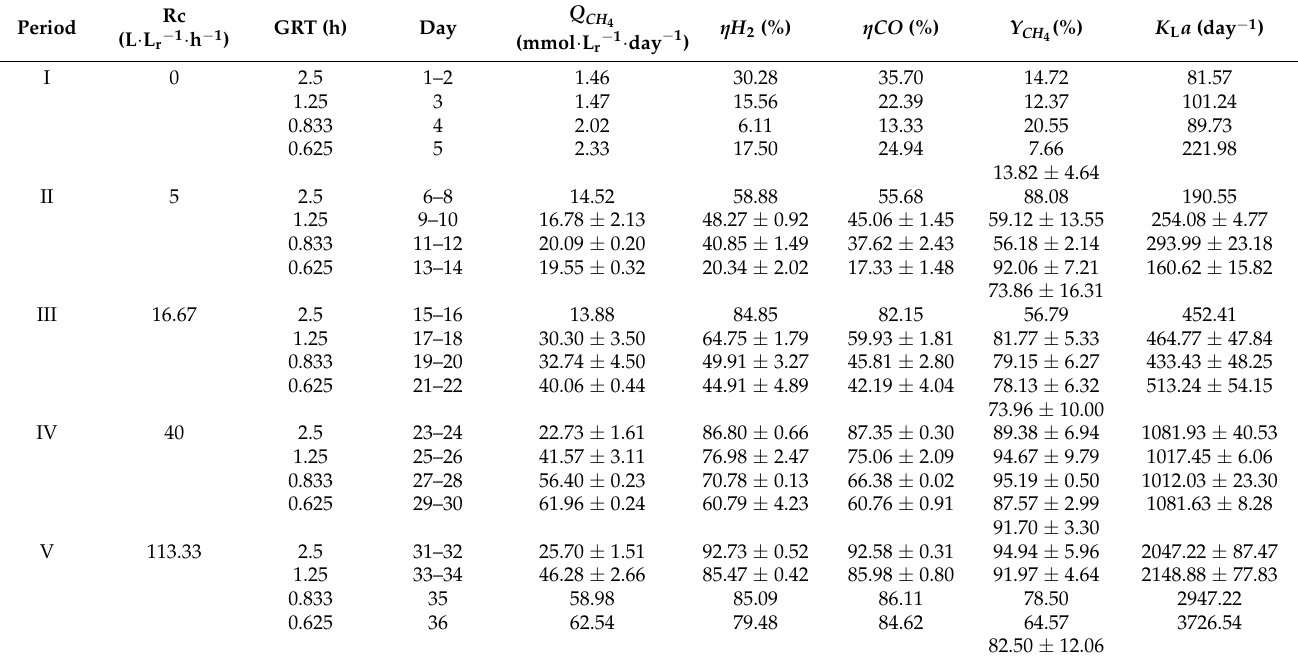
Table 3. Syngas biomethanation performances of the BCR-C in 5 experimental periods at different gas recirculation rates and GRTs.